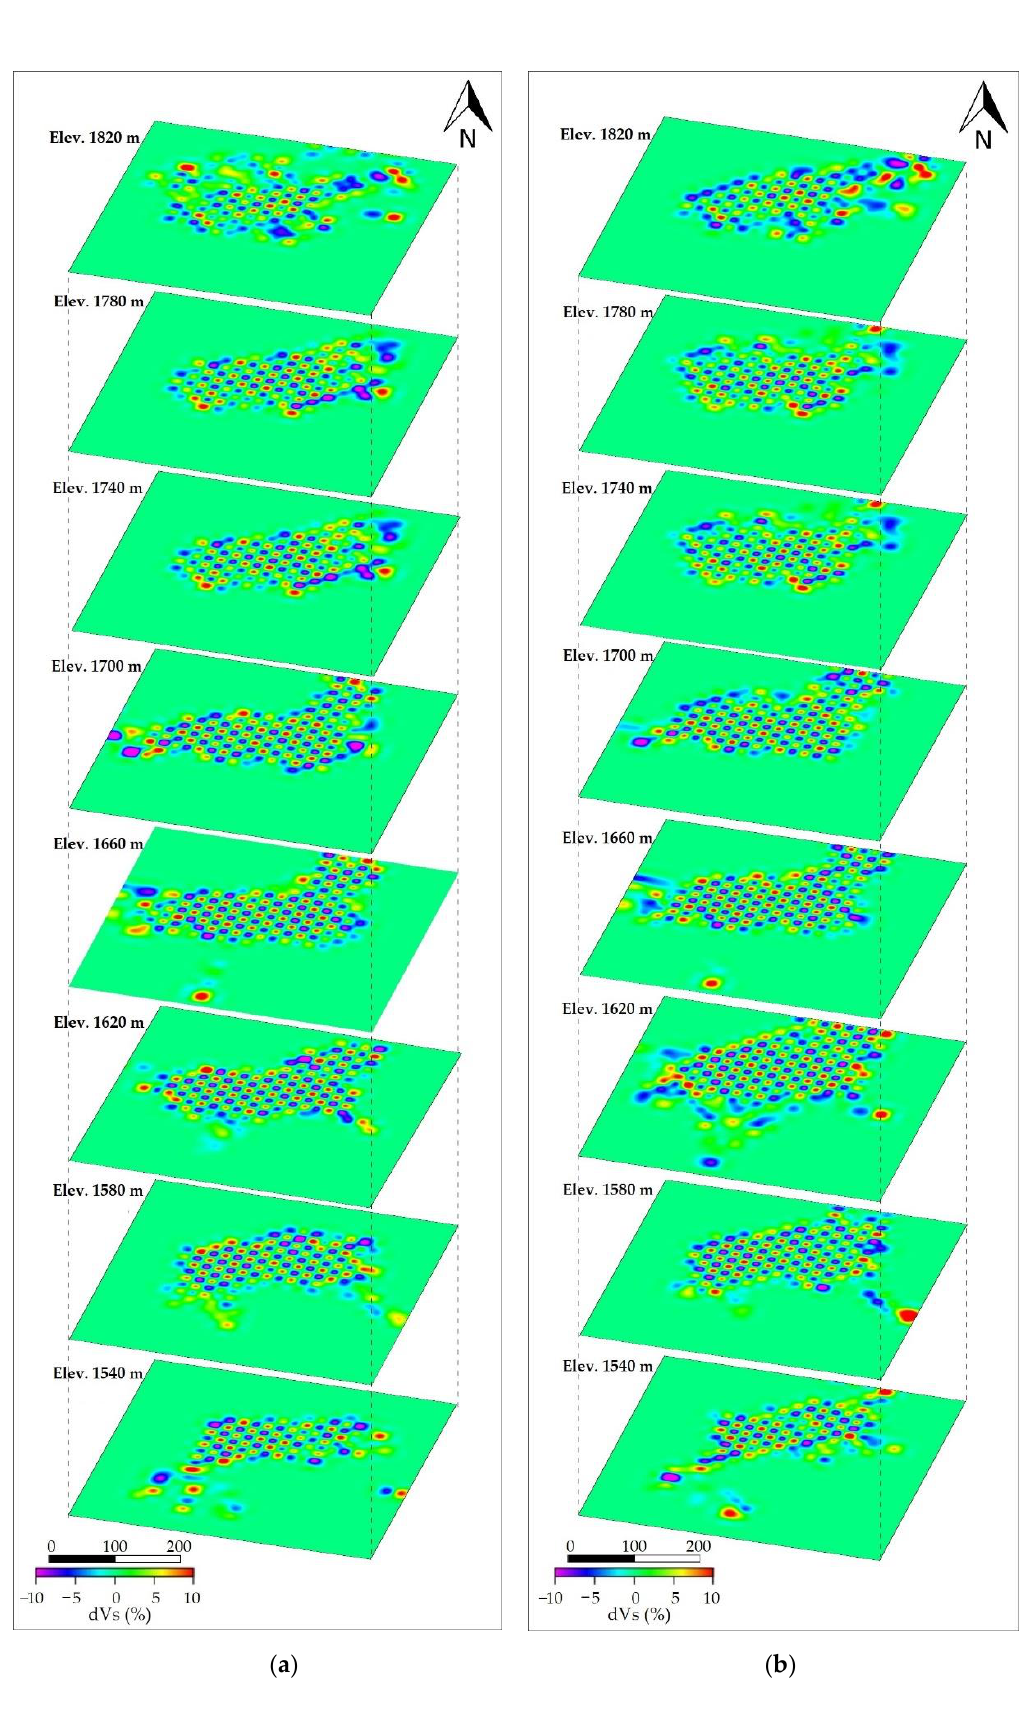
Figure 8. ( a ) Checkerboard Resolution Test Vs following the facility for each elevation at 1540–1820 (interval 40 m). ( b ) Checkerboard Resolution Test Vs following the off-facilities area for each elevation at 1540 – 1820 (interval 40 m).